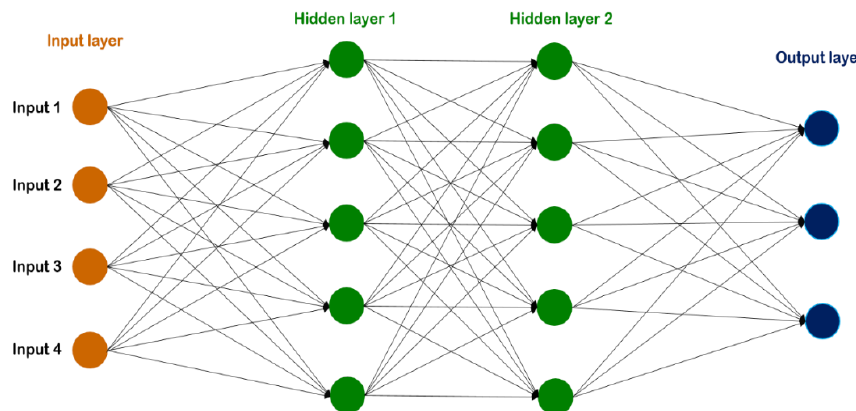
Figure 3. A schematic of neural network architecture, including input, hidden, and output layers .